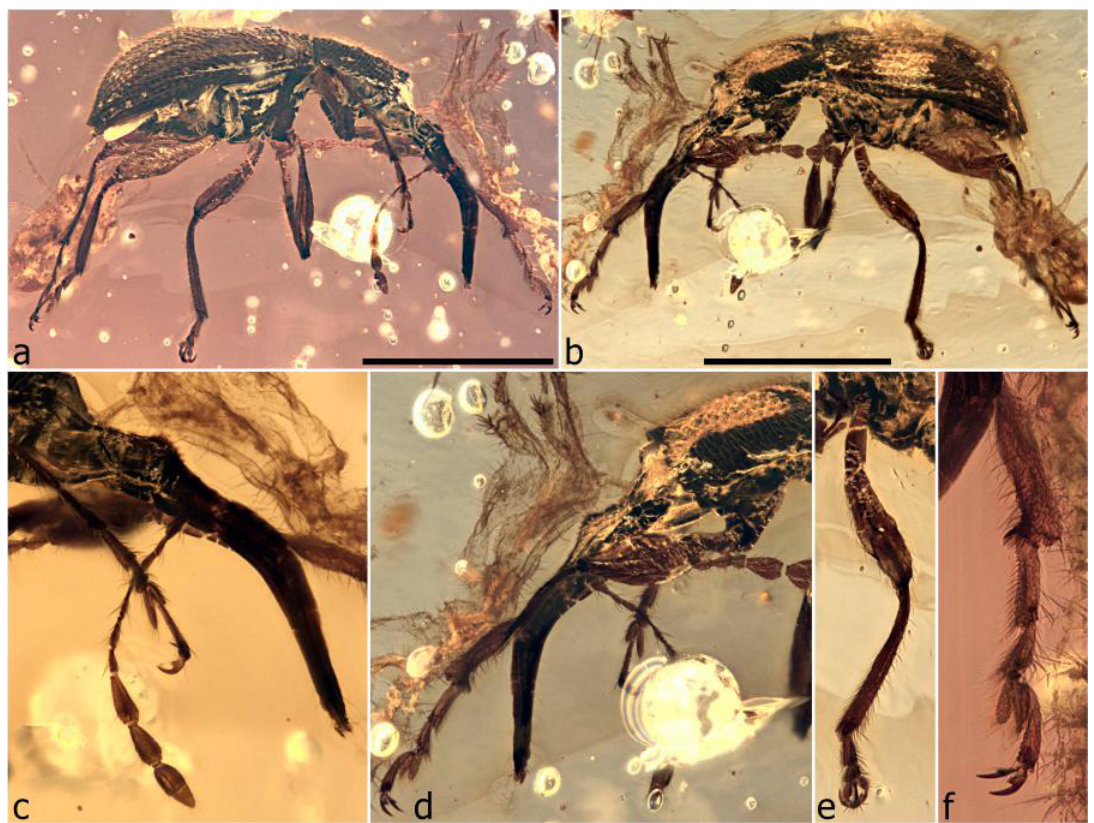
Figure 79. Habropezus incoxatirostris sp. n., holotype. Habitus, right lateral ( a ); habitus, left lateral ( b ); head, antenna and protibia and tarsus, right lateral ( c ); same, left lateral ( d ); left middle leg ( e ); left protibia and tarsus ( f ). Scale bars: 1.0 mm (a,b).